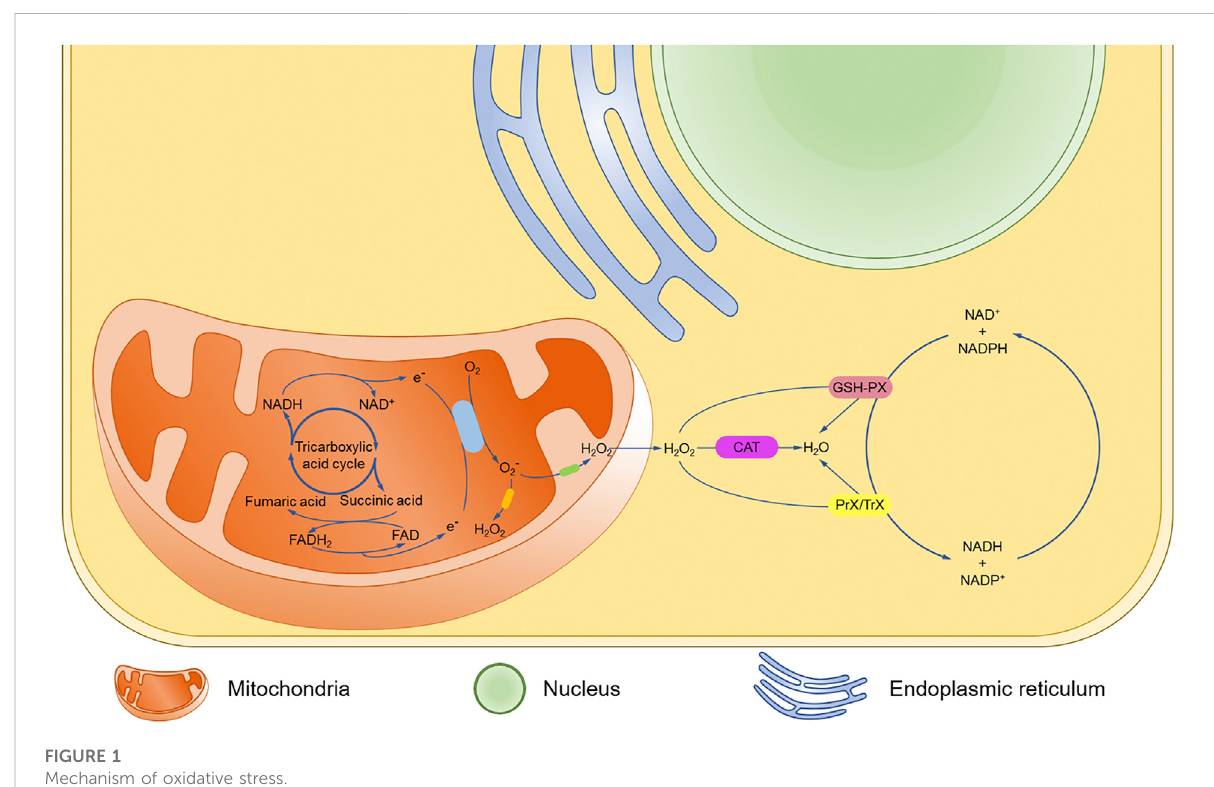
FIGURE 1 Mechanism of oxidative